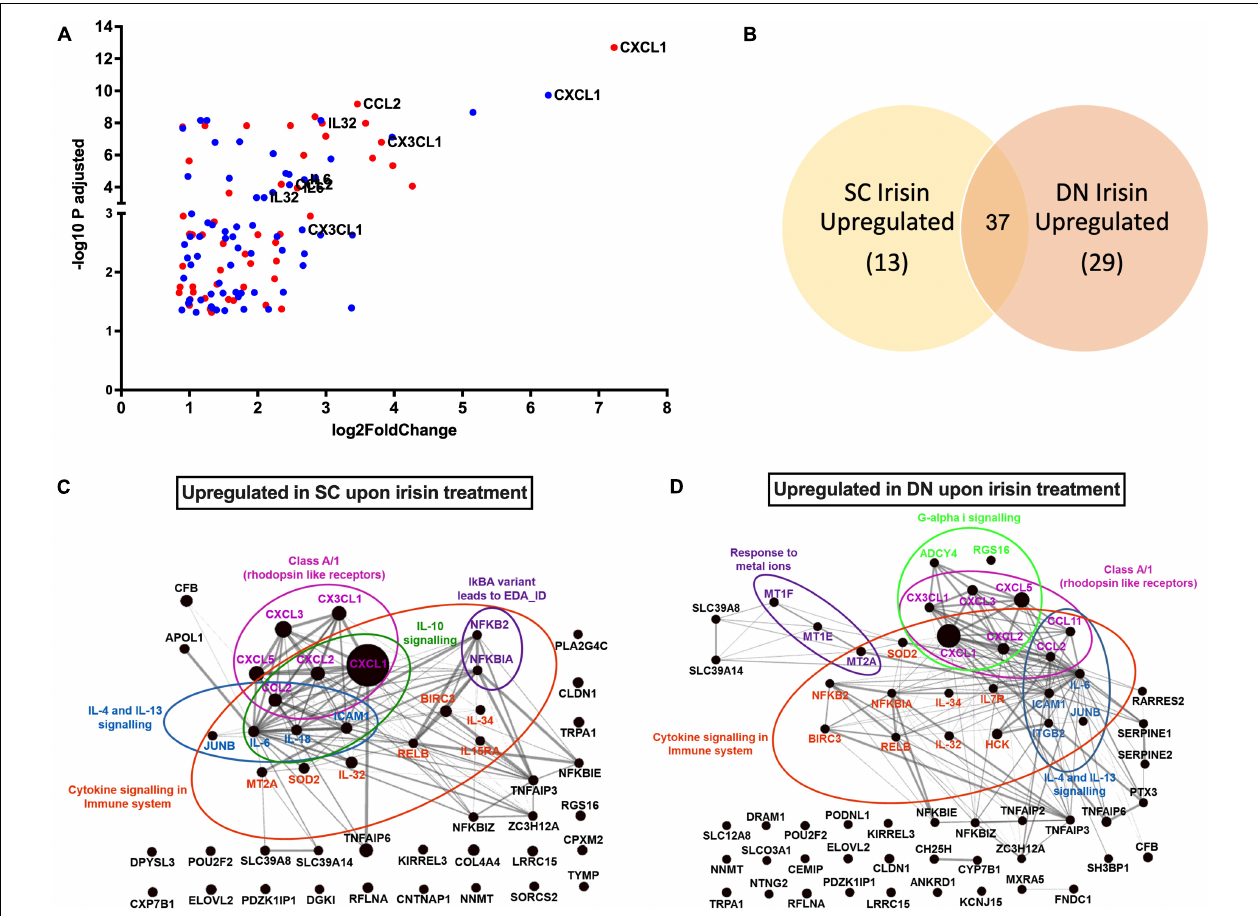
FIGURE 2 | Irisin upregulated similar gene-sets that encode for cytokines in subcutaneous (SC) and deep-neck (DN) depots of human neck area adipocytes. SC and DN preadipocytes were differentiated and treated as in Figure 1 . (A) Volcano plot showing each of the upregulated genes in SC (red) and DN (blue) depots upon irisin treatment; the highest upregulated genes are listed separately, (B) Venn-diagram illustrating the genes commonly upregulated by irisin treatment in SC and DN depots. Gephi illustrations highlighting the most important pathways and the interaction of genes upregulated by irisin treatment in SC (C) and DN (D) derived